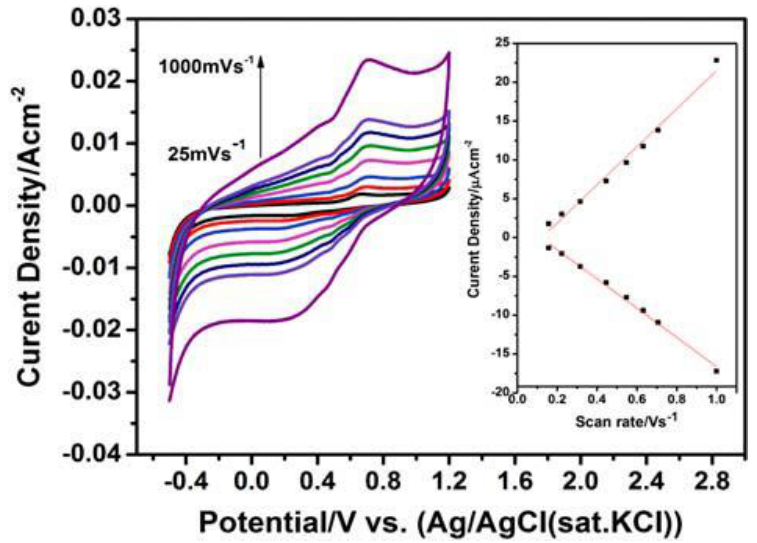
Figure 10. Cyclic voltammetric (CV) curves of 0.1 mM oleuropein (OL) on a TiO-rGO electrode at different scan rates from 25 to 1000 mV s −1 . Taken from Yazar et al. [195].